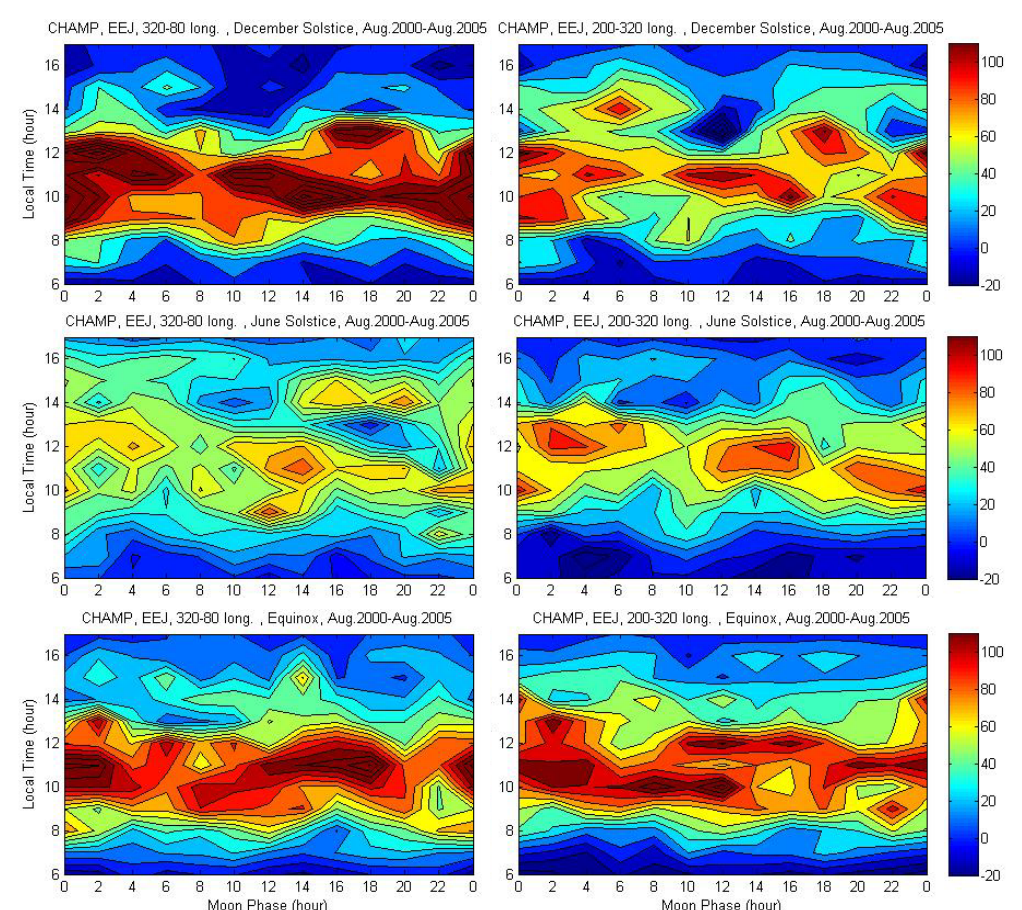
Fig. 5. The same as Fig. 4, but separately for the sectors 320°-80° (left) and 200°-320° of longitudes (right) .